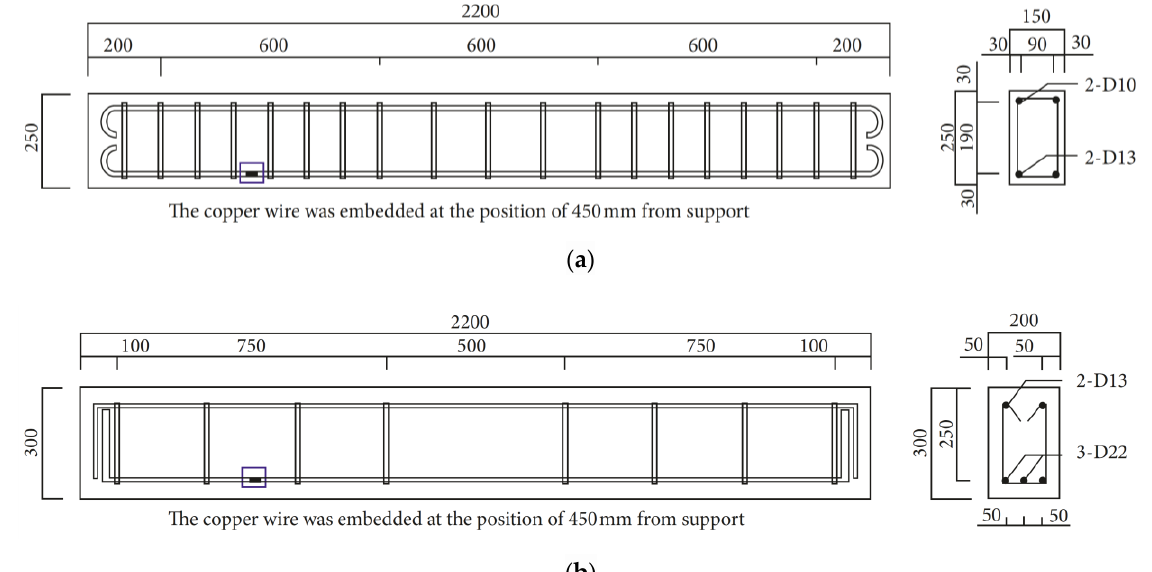
Figure 5. Reinforcement details of beams: ( a ) flexural failure type beam and ( b ) shear failure type